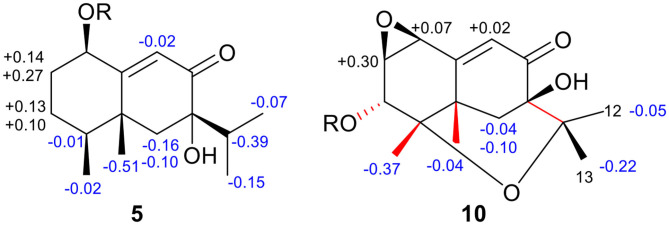
ΔδRS (= δR-δS) values for the (R/S)-MPA esters of 5 and 10.